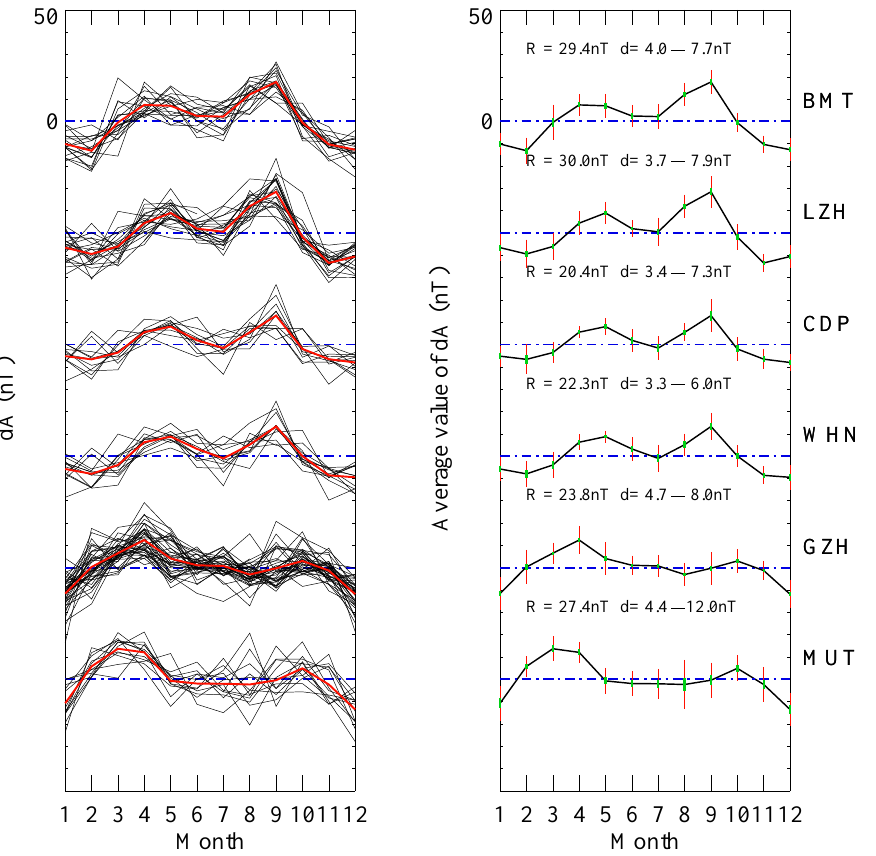
Figure 5. Seasonal variations of the SqH range (dA) over 1957 to 2013. Left panel: stacking curves of the monthly dA for all available years at each observatory. Right panel: average dA over all available observation years, associated standard deviations d (in red short lines), and SEM (in green bars); values of the yearly range R and of the standard deviation d are indicated.